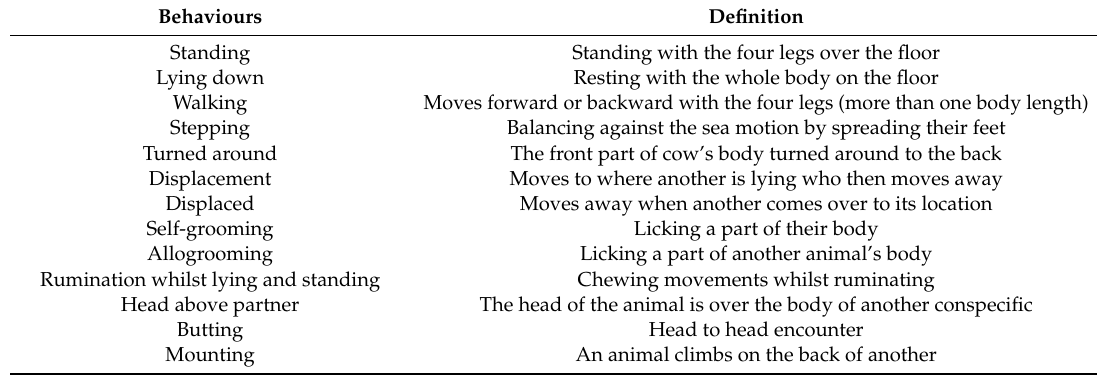
Table 1. Ethogram describing the behaviours recorded for cattle ( n = 12) in High and Low space allowances during two road and one ship